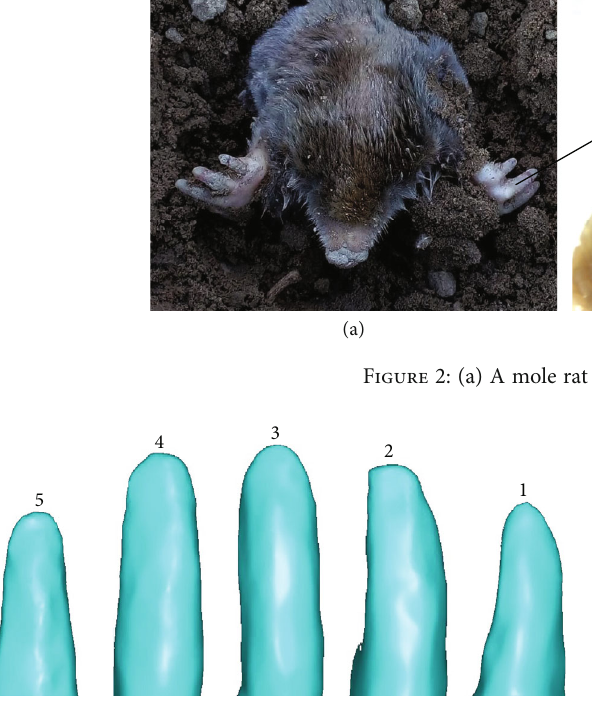
Figure 3: The point clouds and contour curves of the fi ve claws of the mole